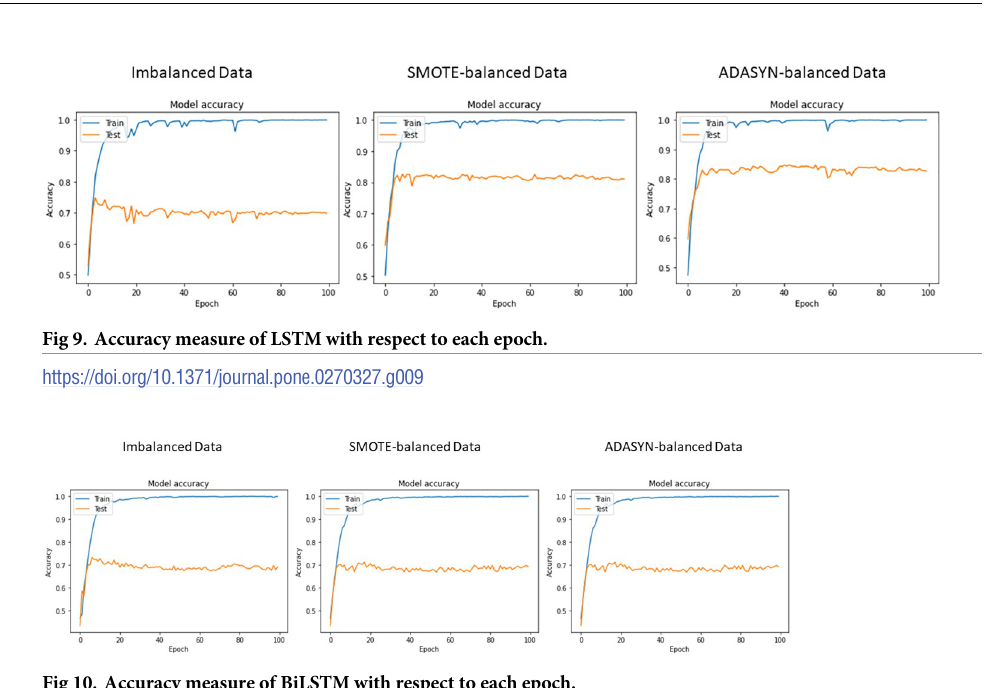
Fig 10. Accuracy measure of BiLSTM with respect to each epoch.